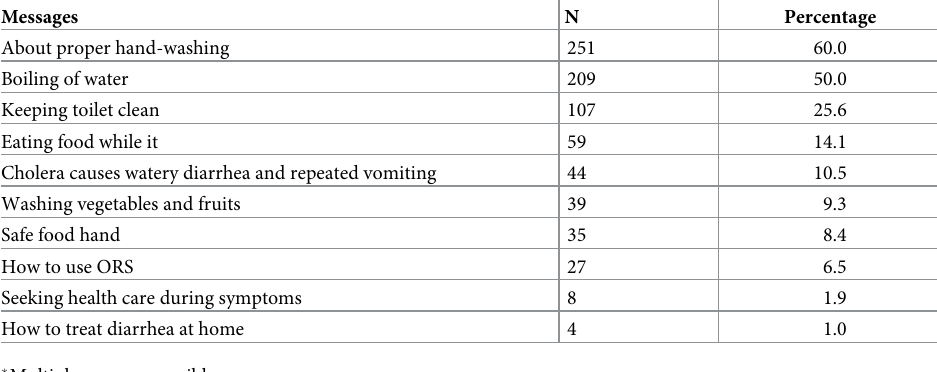
Table 2. Main messages recalled by respondents in Addis Ketema sub-city, Addis Ababa, Ethiopia,